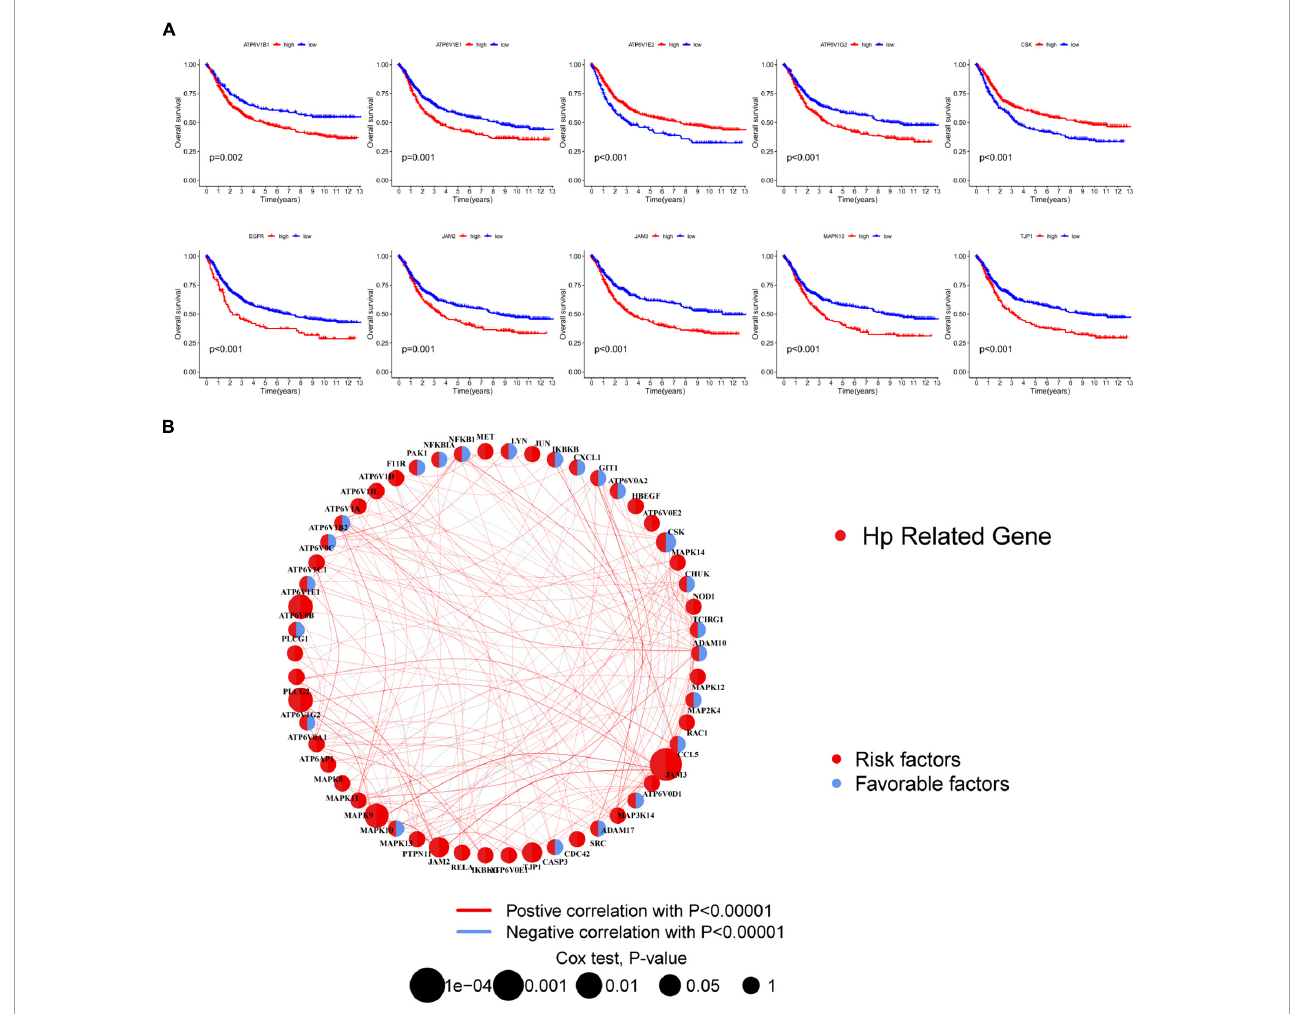
FIGURE3 Survival analysis of HRGs in HP-related GC patients. (A) The Kaplan–Meier survival analysis. (B) Interactions among HRGs. The area of the circles represented the prognostic significance of each gene. The red circles, risk factors; the blue circles, protective factors. The correlation of genes was indicated by lines whose thickness presented the strength of connection. The red lines, positive associations; the blue lines, negative associations. HRGs, HP-related genes; GC, gastric